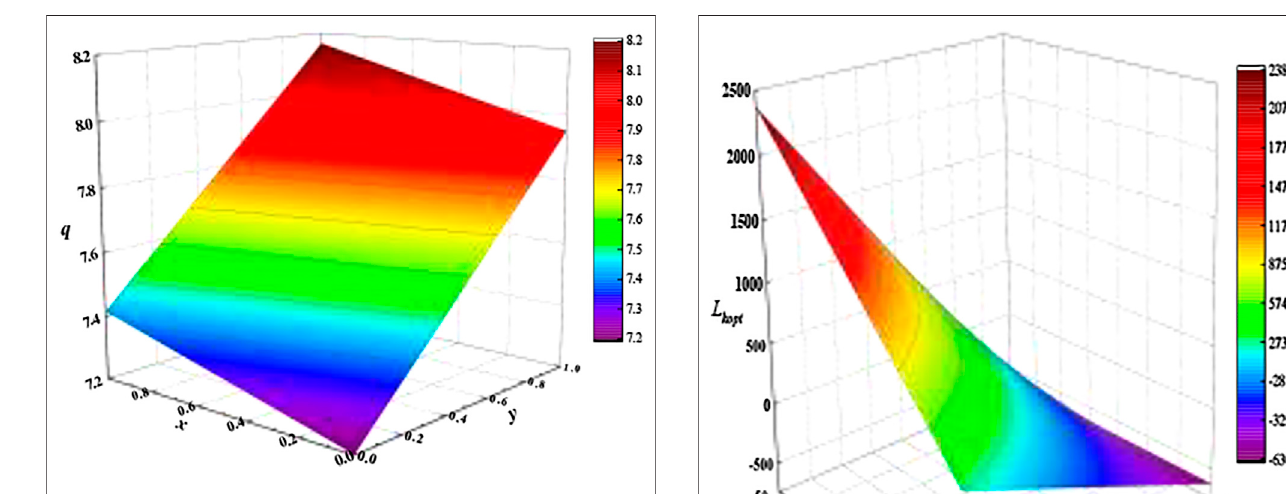
FIGURE 2 | Building materials price and low carbon degree.